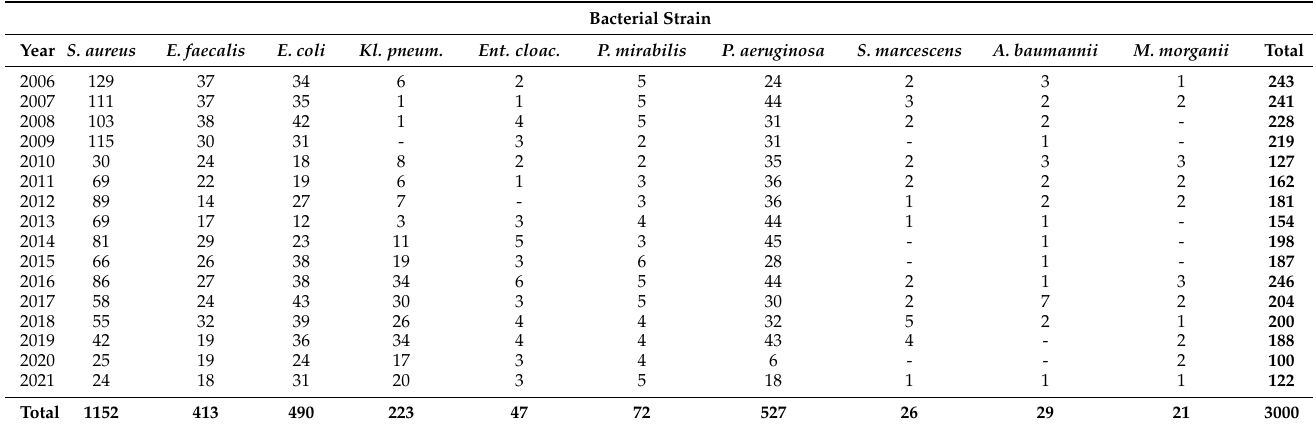
Table 4. The most abundant bacterial strains isolated from PTU patients in the years 2006–2021 (source: internal documentation).